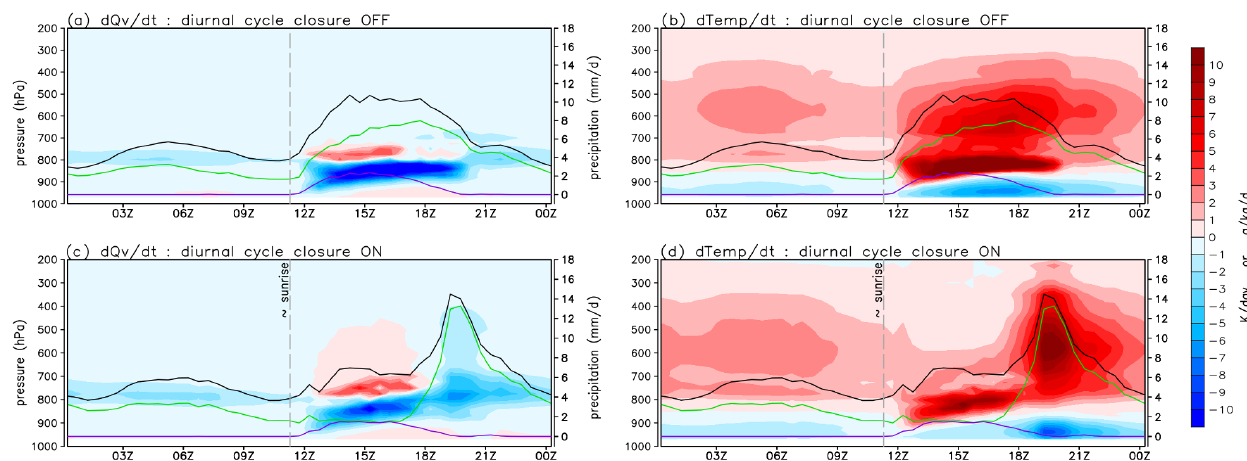
Figure 10. Time average of the diurnal cycle of the grid-scale vertical moistening (a, c) and heating (b, d) tendencies associated with the three convective modes (shaded colors) and precipitation (contour: red dashed, green solid, and purple dashed represent the total precipitation and the convective precipitation from deep and congestus plumes, respectively). The upper (bottom) panels show results without (with) the diurnal cycle closure.